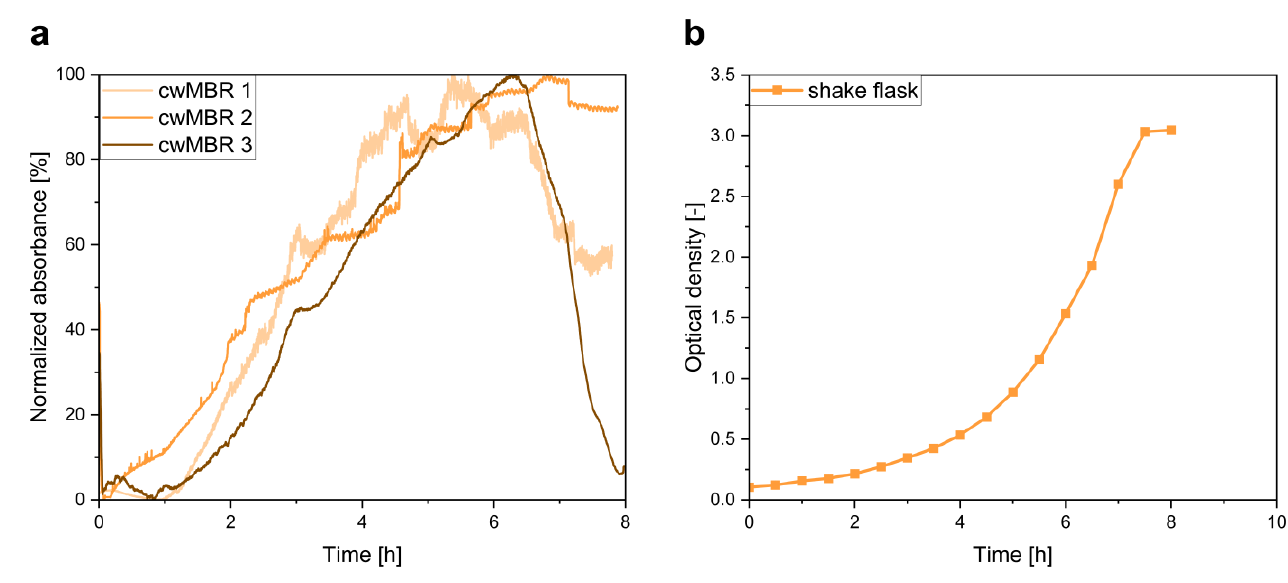
Figure 6. ( a ) Normalized absorbance of an E. coli cultivation in M9 minimal medium in three parallel cwMBRs showing cell growth in all cwMBRs. Vertical oscillation of the cwMBR platform was performed at 70 Hz and an amplitude of 5%. The absorbance was measured using a blue LED and a miniaturized spectrometer; ( b ) optical density of E. coli cultivated in shake flasks with M9 medium. The graph shows the mean of a triplicate.